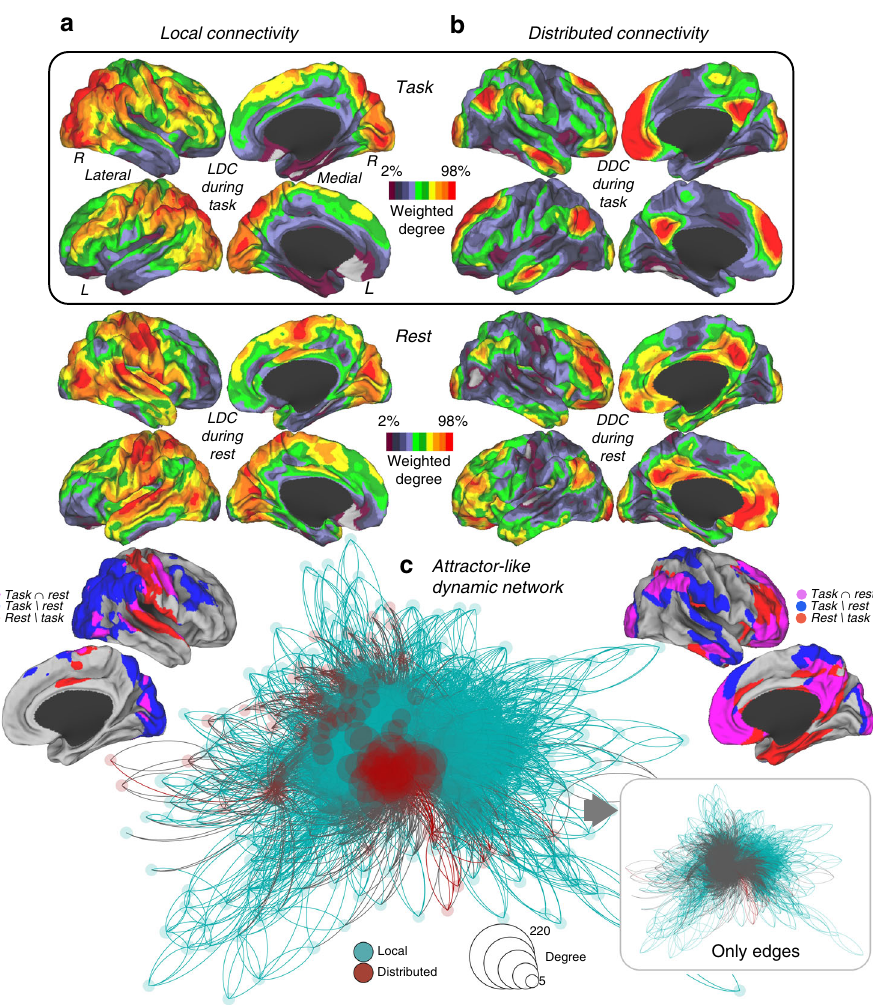
Fig. 3 a , b Average maps of all task domains and overlap map with resting-state dynamic connectivity patterns. c Local and distributed connectivity in the network topological space is displayed. The size and color of the nodes are based on the degree of local and distributed connectivity. The degree centrality (degree of connectivity) shows higher values as larger nodes. The size and color of links are based on the subtraction between local and distributed SFC scores. LDC local dynamic connectivity, DDC distributed dynamic connectivity. Local is in blue color and distributed red